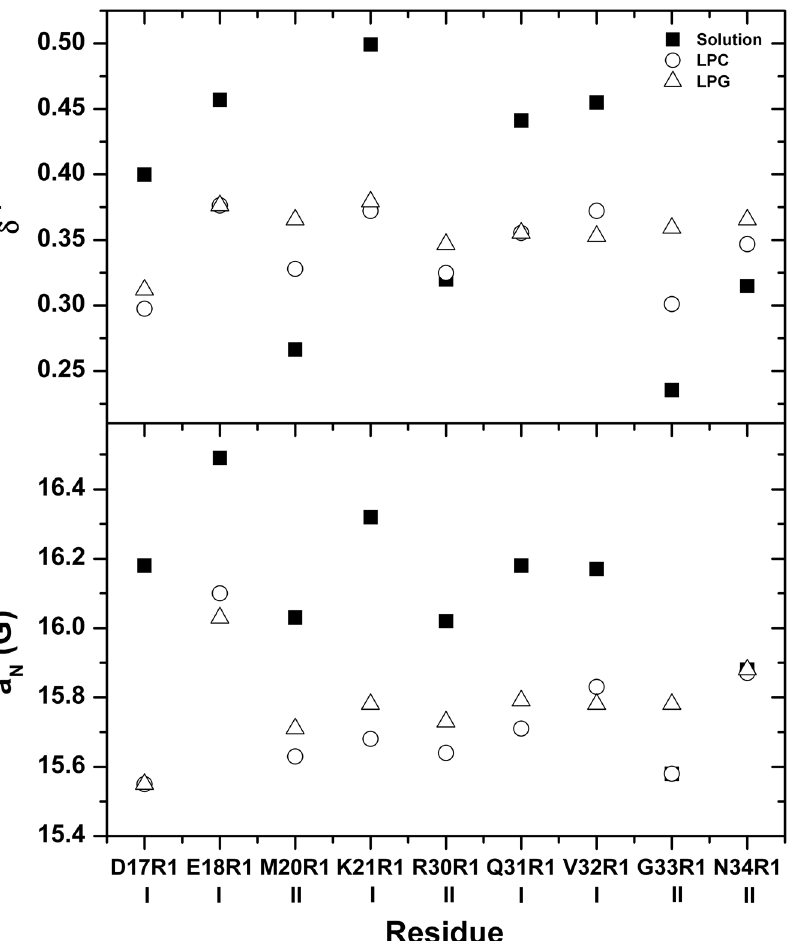
Figure 5. (Top) Calculated parameter d 2 1 as a measure of backbone dynamics of R1 in solution (black squares) and in the presence of LPC (open circles) or LPG (open triangles) micelles. (Bottom) Calculated values of isotropic hyperfine coupling (a N ) for the ESR spectra of B- FABP mutants in solution (black squares) and in the presence of LPC (open circles) or LPG (open triangles) micelles. The mutants were divided in two groups (I and II) according to their response to the presence of the membrane model. Group I mutants presented decreased mobility (lower d 2 1 values) of the R1 side chain in the presence of LPC or LPG micelles. G33R1 was the only mutant showing different responses in terms of a N variations.